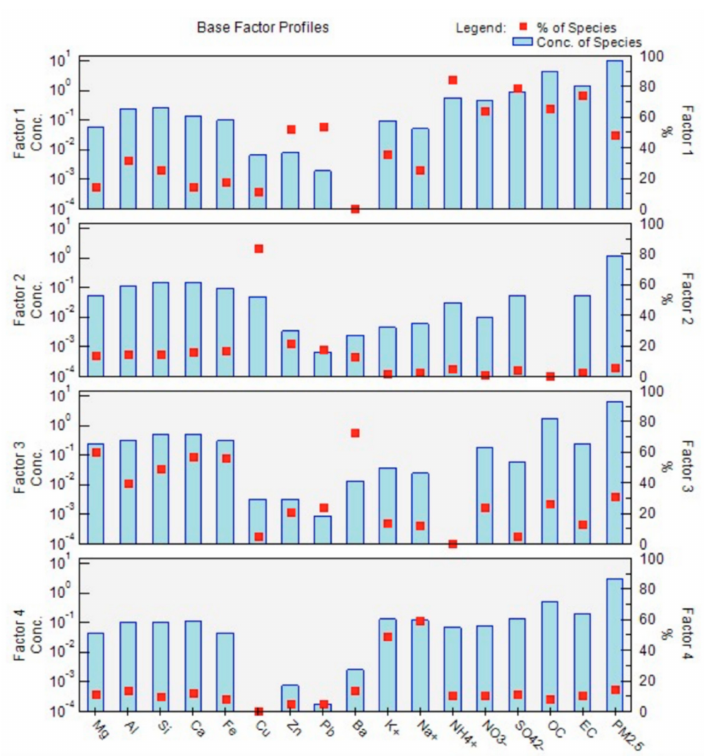
Figure 6. Factor profiles: division of elements into individual factors, and their characterization from measurements of PM 2.5 taken in the wet season in Baoshan.